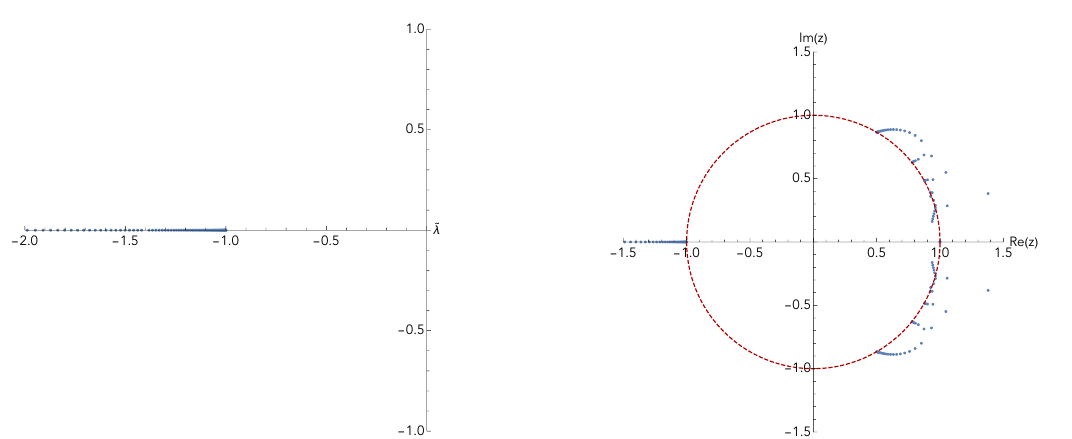
Figure 2 . Padé poles of tr M from 150 terms. On the left, we show the poles of the direct approximants. These poles lie on the negative real axis and accumulate to ˜ λ = − 1 . On the right we show the poles in z -plane after application of the conformal transformation (6.4) followed by Padé. In this case collinear singularities on the line ˜ λ ∈ ( −∞ , − 1] are separated and made visible as arcs converging to points on the unit circle in the z plane. These agree with a similar analysis for the whole ∆ F , see (6.5).